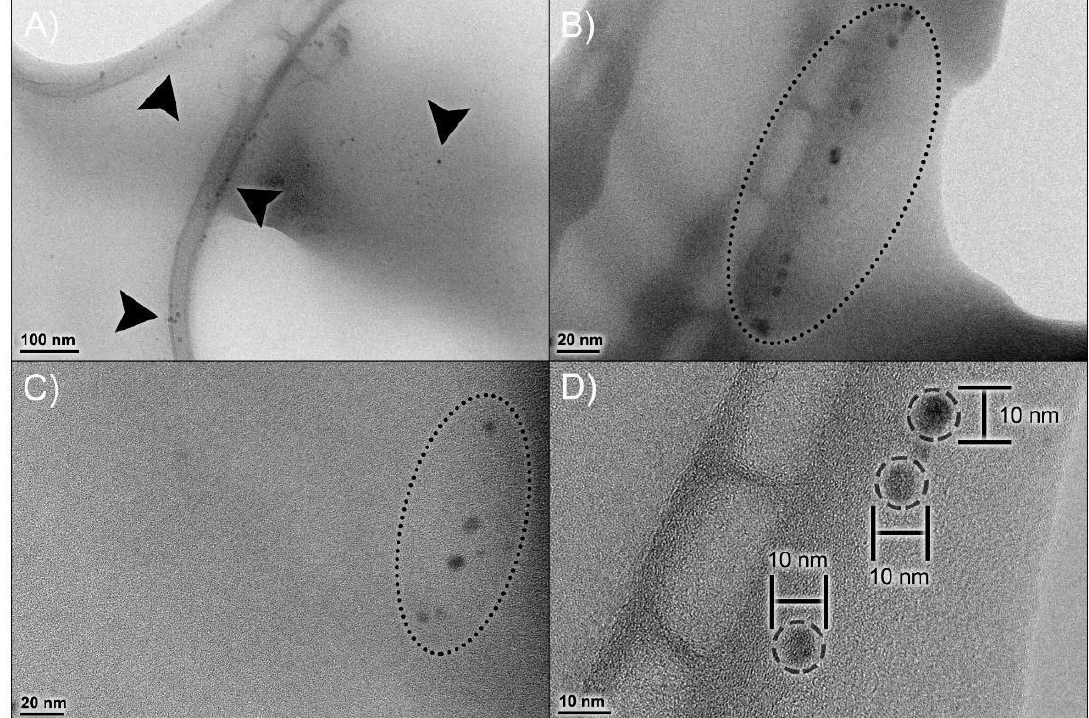
Figure 2. Morphological profile of npBX. Transmission Electron Microscopy (TEM) micrographs